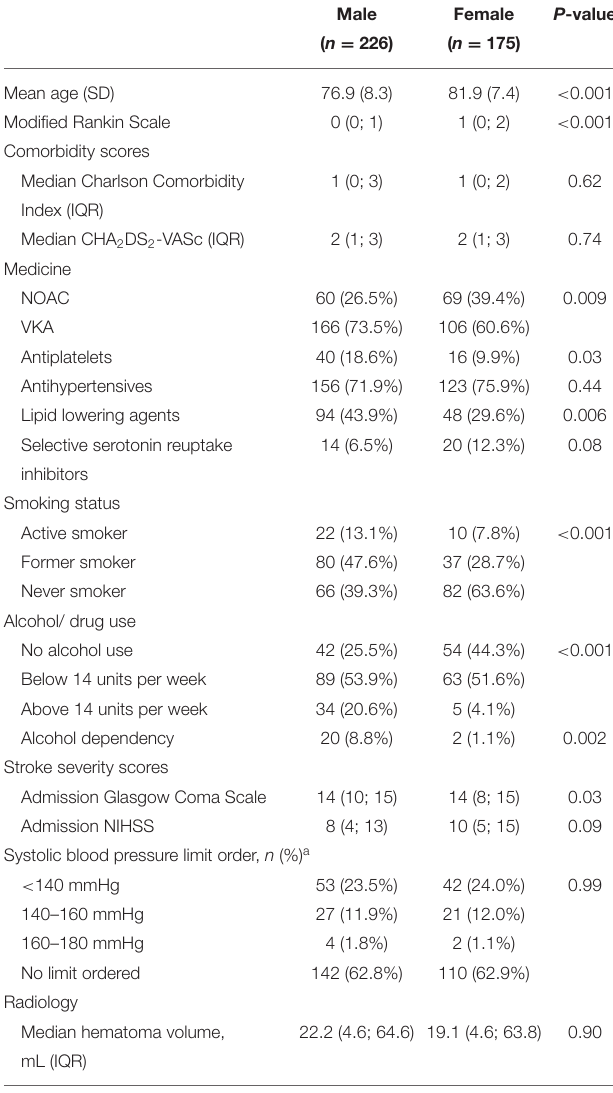
TABLE 1 | Baseline data in 401 men and women with oral anticoagulant (OAC)-related intracerebral hemorrhage